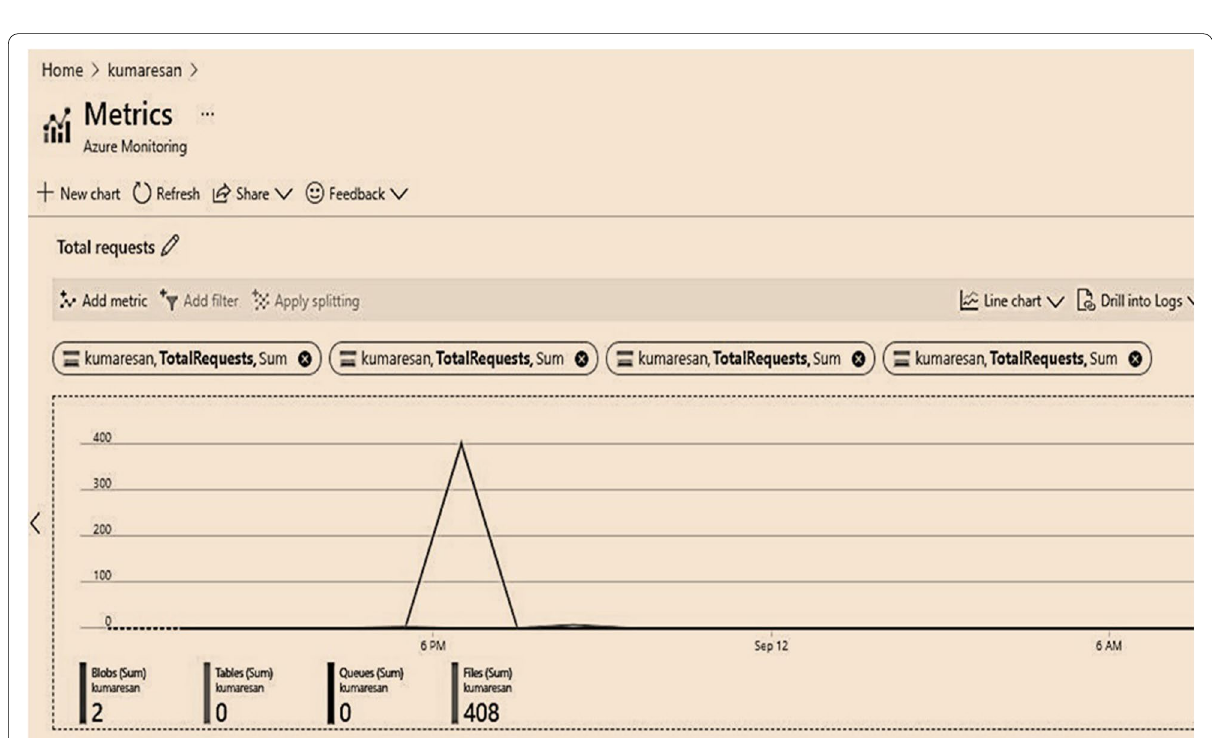
Fig. 9 Monitoring metrics for VM1 TEST1 Z